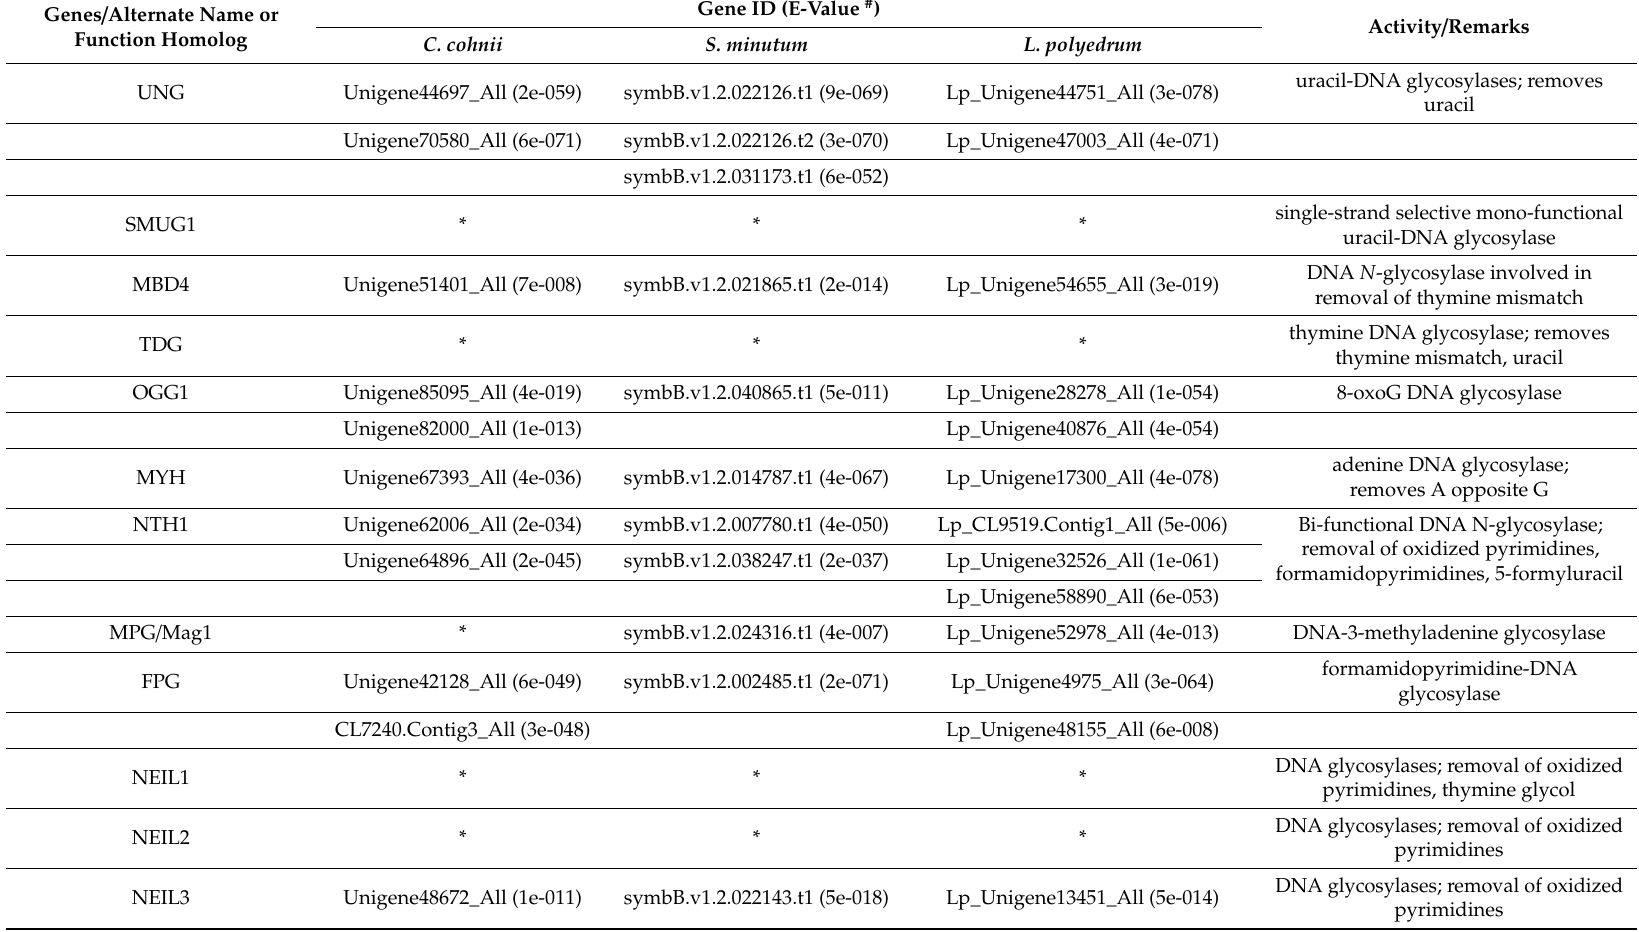
Table 3. Predicted dinoflagellate orthologues in base excision